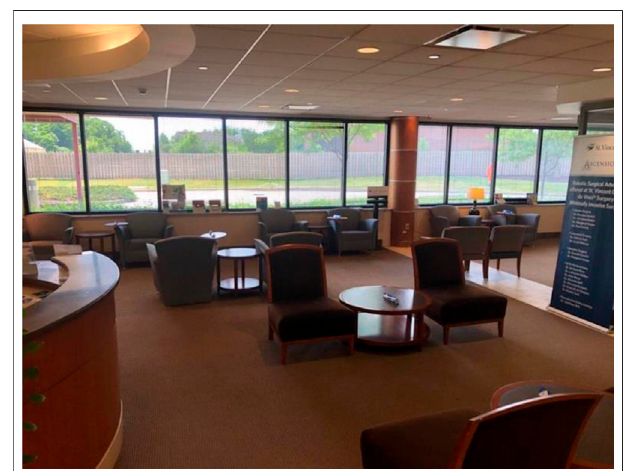
FIGURE4| Waitingarea:HospitalinCarmel,Indiana(2019),photograph by Lisann